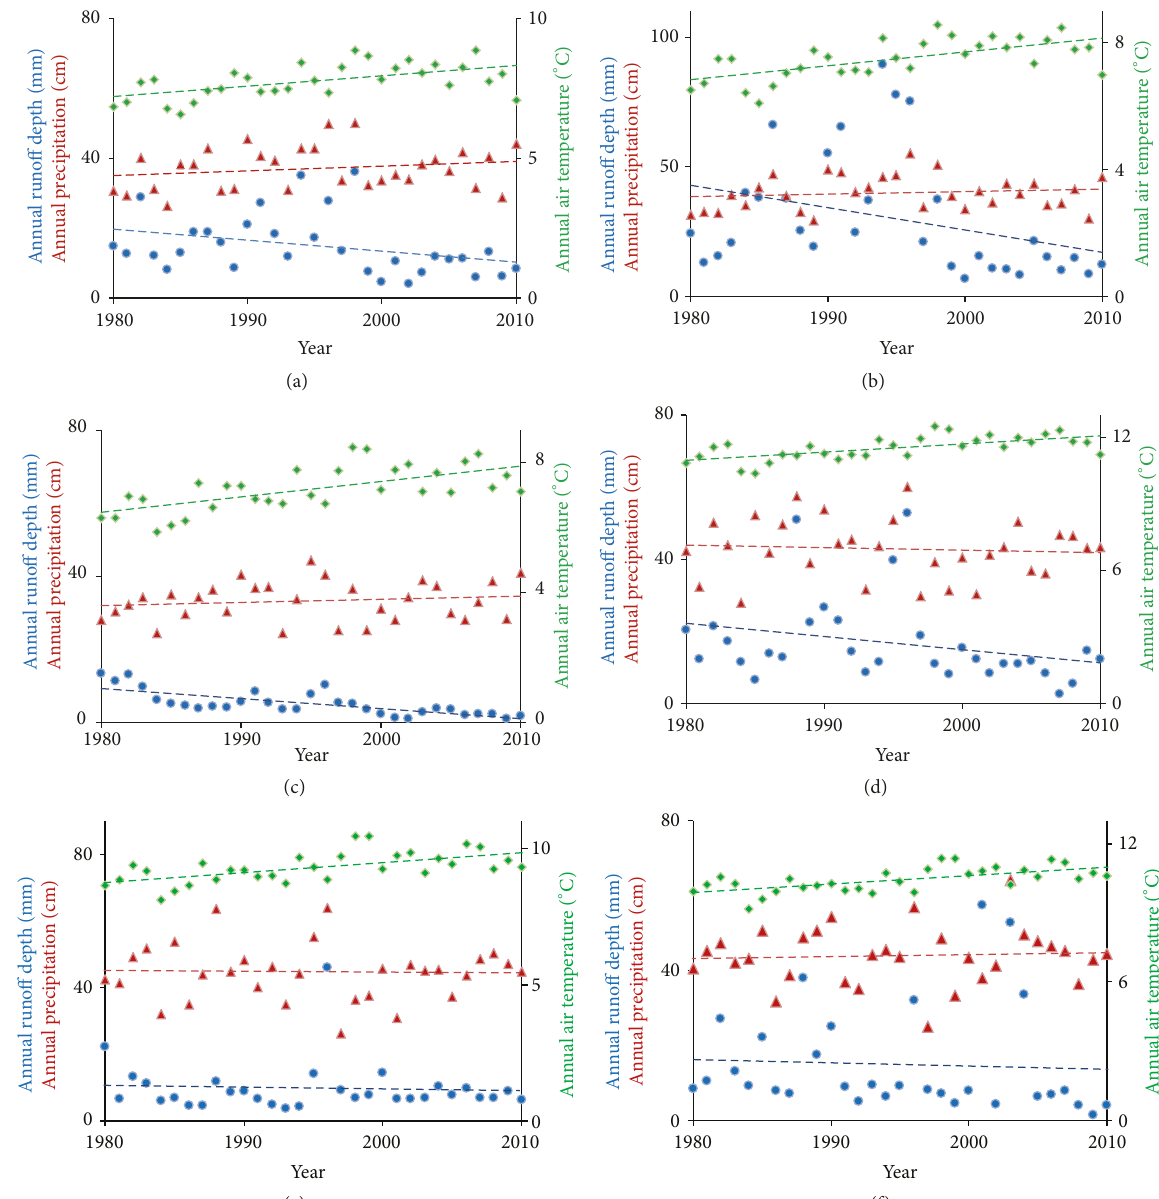
Figure 2: Tendency of annual runoff depth (blue circle), precipitation (red triangle), and air temperature (green diamond). The dashed lines represent the linear fitted trend from 1980 to 2010. (a) is Luan River Basin (LRB), (b) is Chaobai River Basin (CRB), (c) is Yongding River Basin (YRB), (d) is Daqing River Basin (DRB), (e) is Ziya River Basin (ZRB), and (f) is Zhang River Basin (ZhRB).